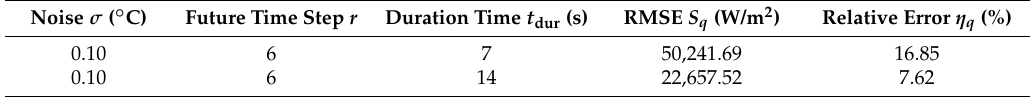
Table 5. Error analysis for heat flux inversion under continuous